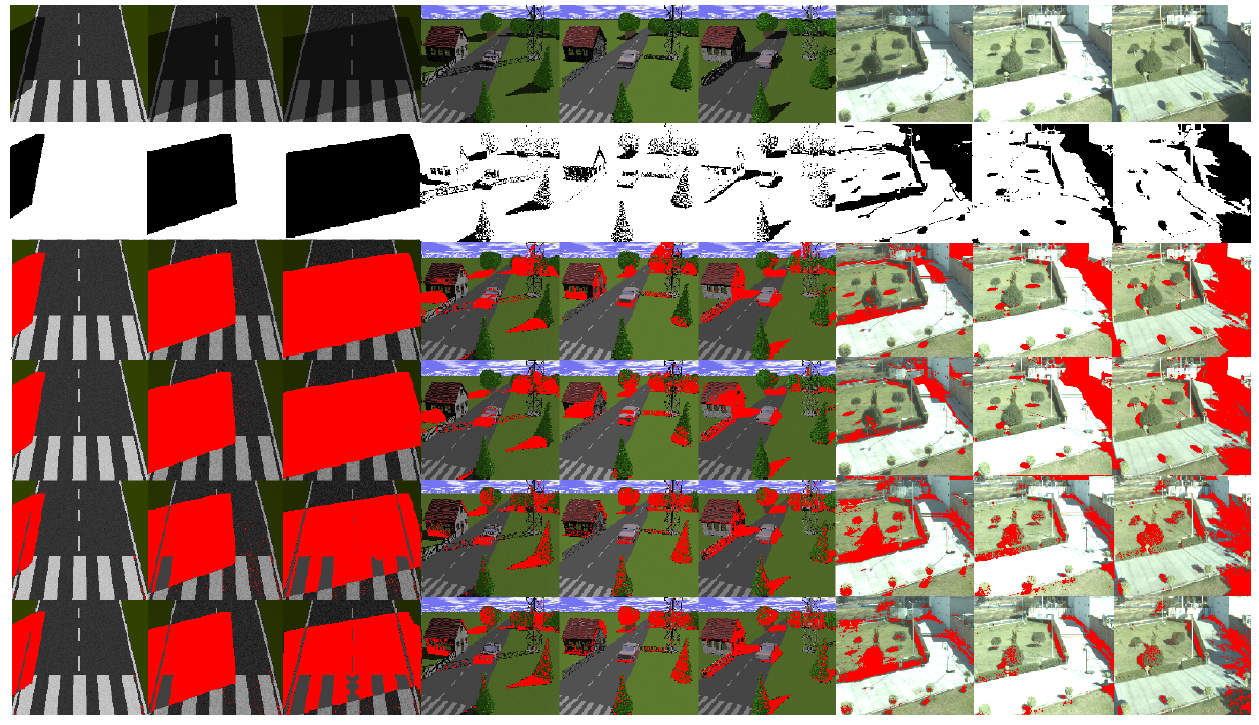
Figure 5. Qualitative results in the synthetic data set. The first and second rows are input and ground truth of shadows. The third, fourth, fifth, and sixth rows are the results of the